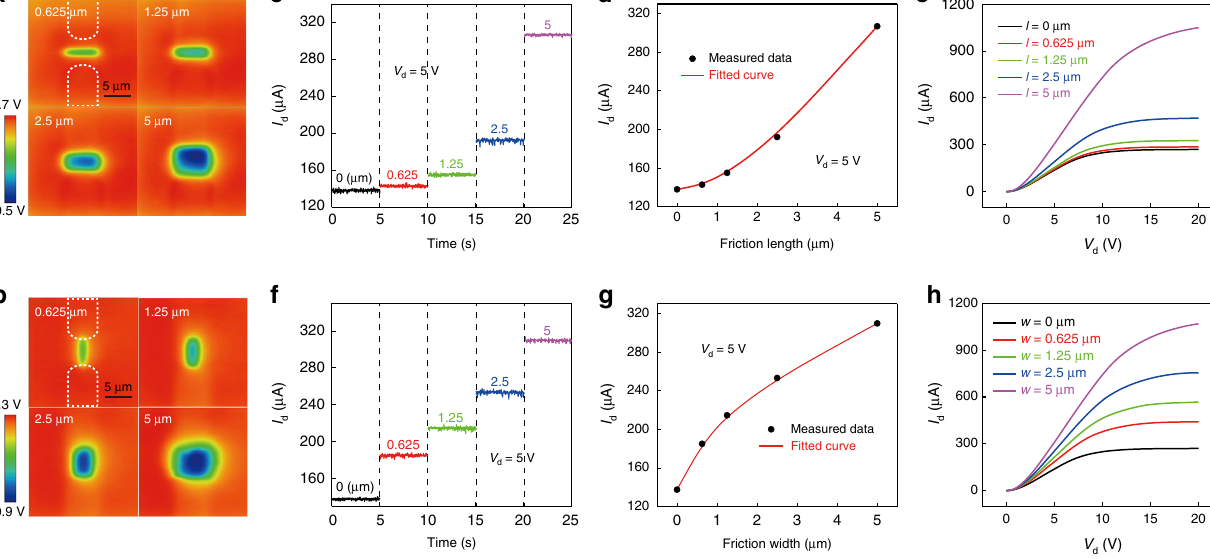
Fig. 2 The effect of contact cycles on the characteristics of the NTT. a Surface potential distribution of the NTT after regionally rubbed by the AFM tip with increasing contact cycles. b The corresponding potential distribution in cross-sectional view. c The potential difference between the rubbed and surrounding area with increasing contact cycles. d I d output characterisics at a drain voltage of 5 V with different contact cycles from 0 to 3. e The I d – n transfer characteristics. f I d – V d output characteristics with different contact cycles. All error bars in the fi gure represent s.d. of the data. e